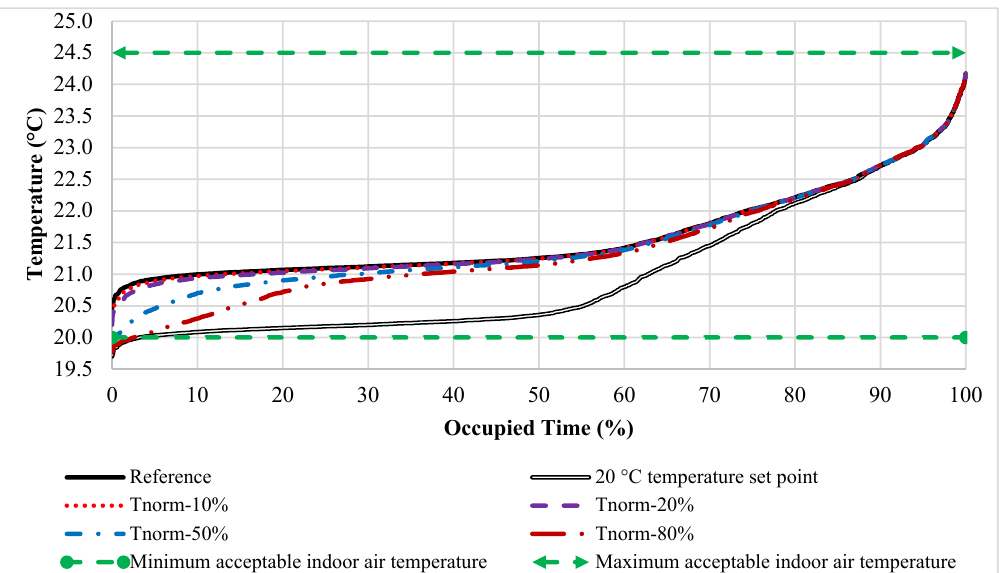
Figure 10. Indoor air temperatures of the coldest room (namely, office room 8) during the occupied hours (2835 h) with and without DR control. Table 6. Peak demand limiting cases.